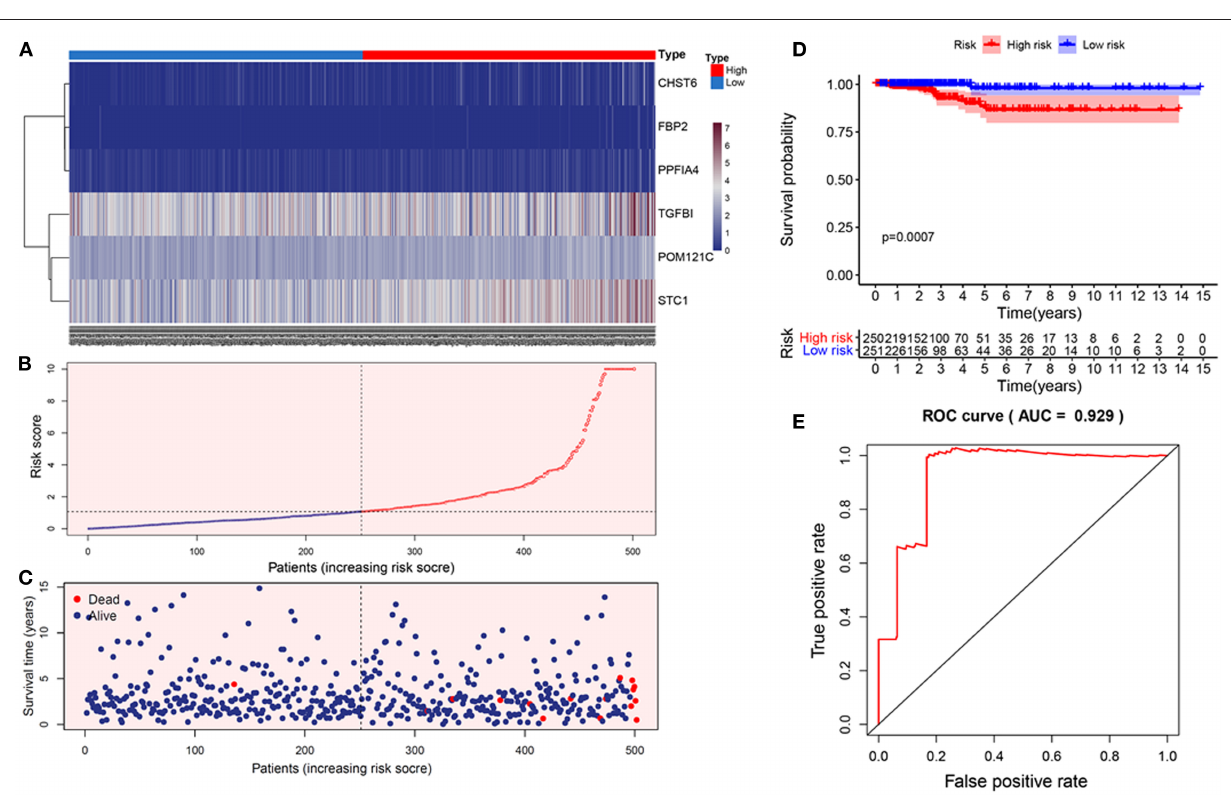
Frontiers in Oncology | www.frontiersin.org